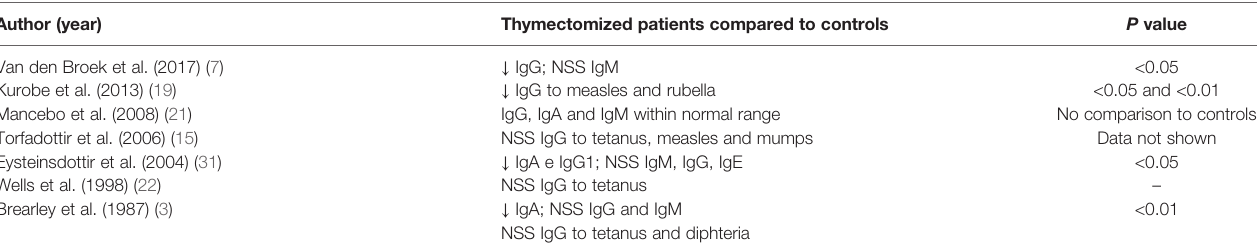
TABLE 9 | Main results regarding levels of immunoglobulins of included